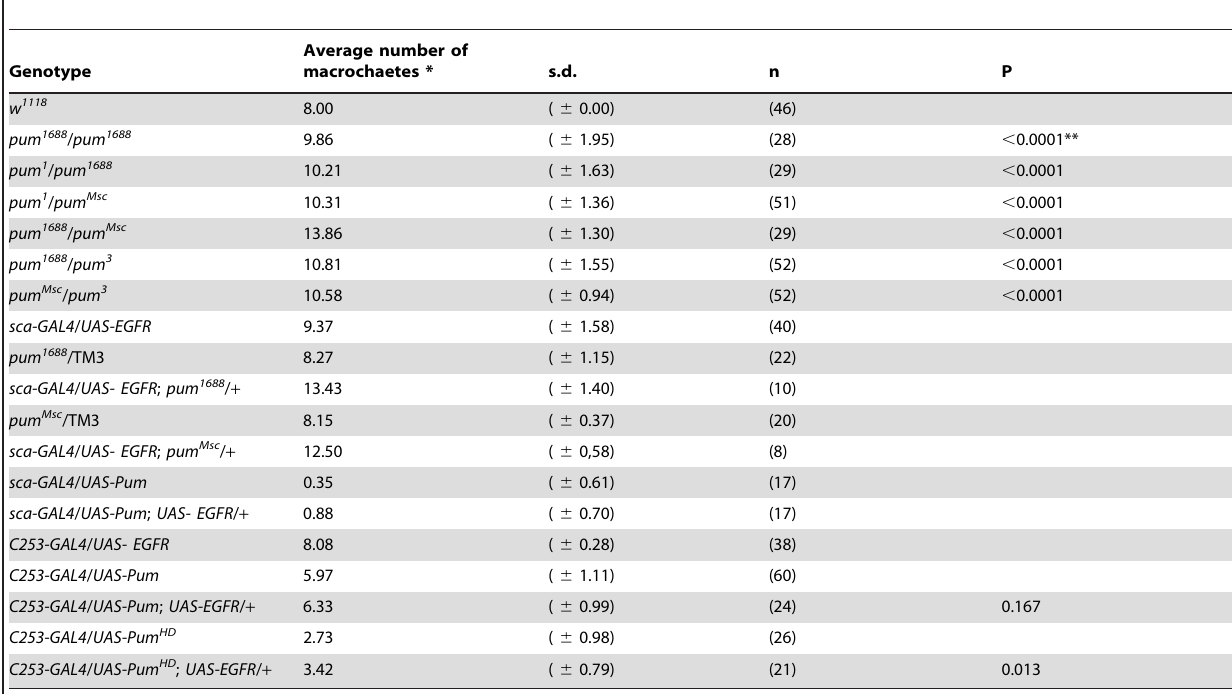
Table 1. The number of macrochaetes reveals genetic interaction between Pum and EGFR.